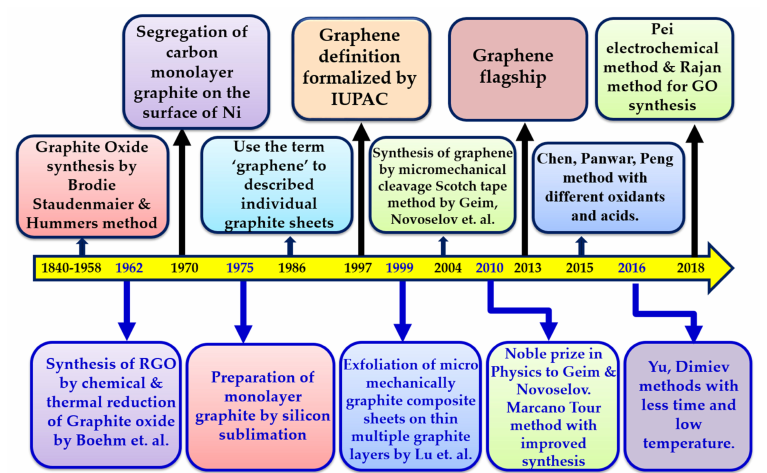
Figure 2. Schematic representation of a graphene